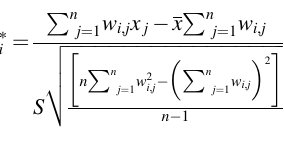
where i and j are two separate features, w i,j is the spatial weight between these features (described in Figure 1), x j is the value of the feature j (the feature being evaluated in this instance), n equals the total number features being considered, while x and S equal: